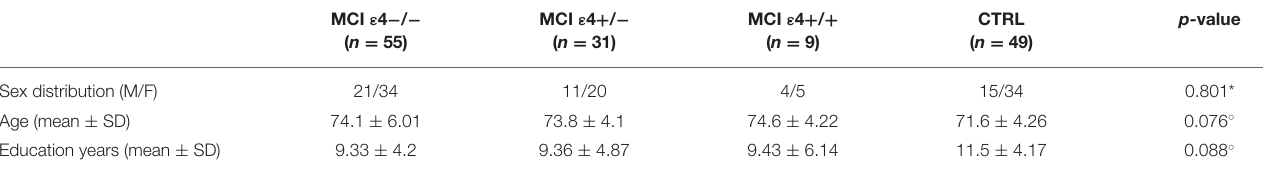
TABLE 1 | Clinical and demographic characteristics in MCI patients and healthy